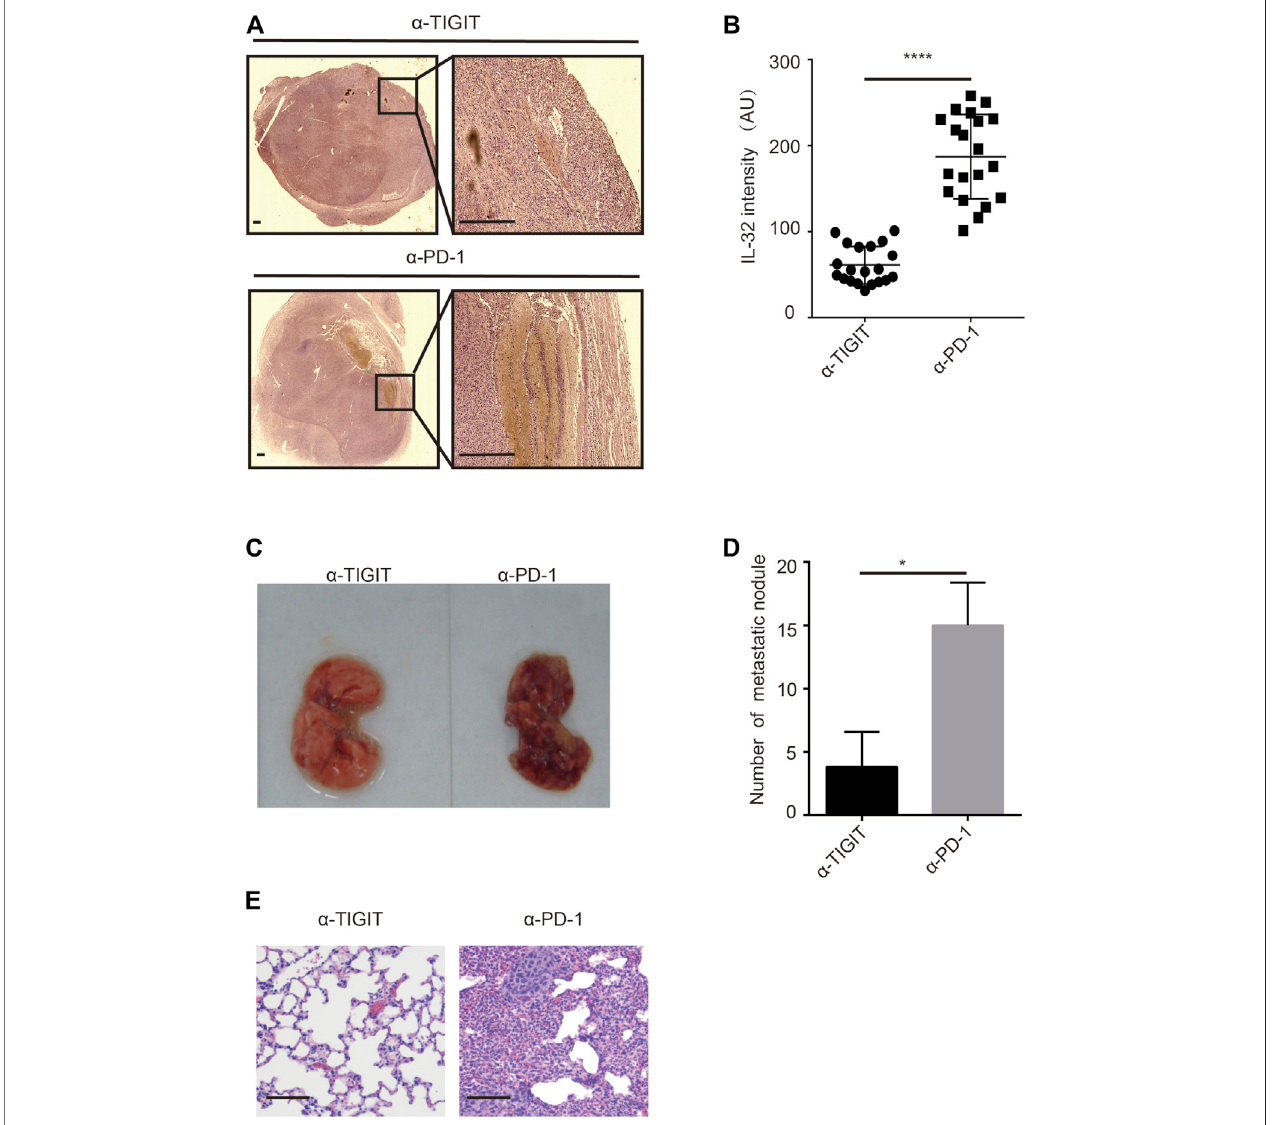
FIGURE 6 | Targeting TIGIT inhibits the metastasis of bladder cancer through suppressing IL-32. (A , B) Targeting TIGIT suppresses the expression of IL-32. Immunohistochemistry images showing the expression of IL-32 in bladder tissues collected from different groups of animals. Scale bar (cid:1) 1 mm (A) . The levels of expression of IL-32 are shown as the mean ± SD. **** p < 0.0001; t -test (B) . Data are representative of four independent experiments (n (cid:1) 7). (C − E) Targeting TIGIT inhibits the metastasis of bladder cancer. Metastatic nodules in lungs of mice inoculated with bladder cancer cell lines (C) . The number of metastatic nodules is shown as themean ± SD. * p < 0.05; t -test (D) . Images showing HE-stained bladder tissues collected from different groups ofanimals. Scale bar (cid:1) 100 μ m (E) . Data are representative of four independent experiments (n (cid:1) 7).